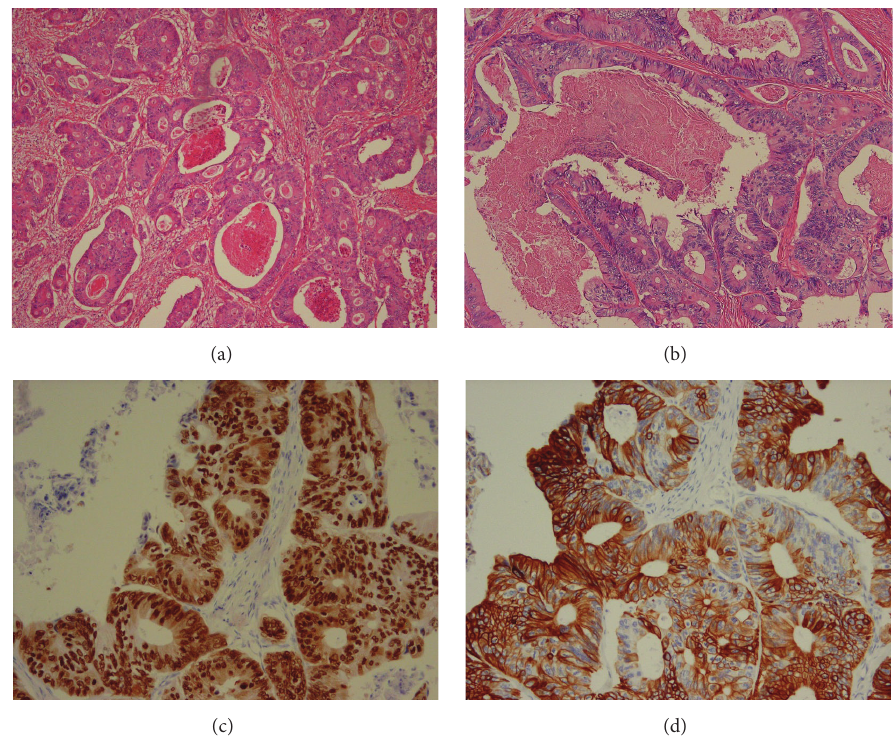
Figure 1: Histopathology. (a) Primary cecal cancer reveals moderately differentiated adenocarcinoma. (b) Spermatic cord tumor shows moderately differentiated adenocarcinoma, which is compatible with a metastasis from the cecal cancer. (c) Immunohistochemical staining indicates caudal-type homeobox- (CDX-) 2 positive in the spermatic cord tumor. (d) Immunohistochemical staining shows cytokeratin- (CK-) 20 positive in the spermatic cord tumor.